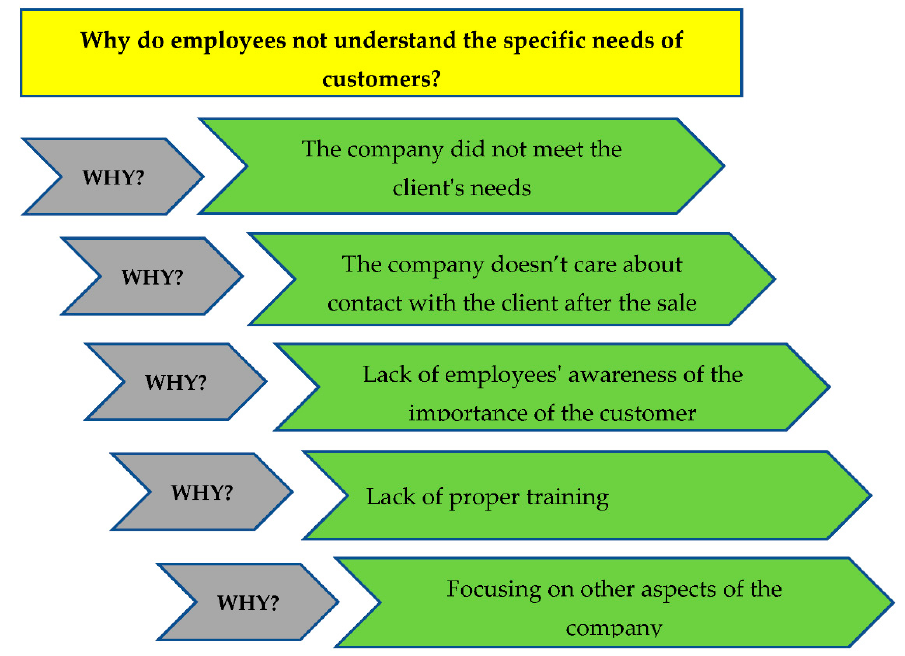
Figure 6. Pareto–Lorenz diagram causes of customer dissatisfaction with the quality of energy ser- vices by frequency of occurrence. services by frequency of occurrence.